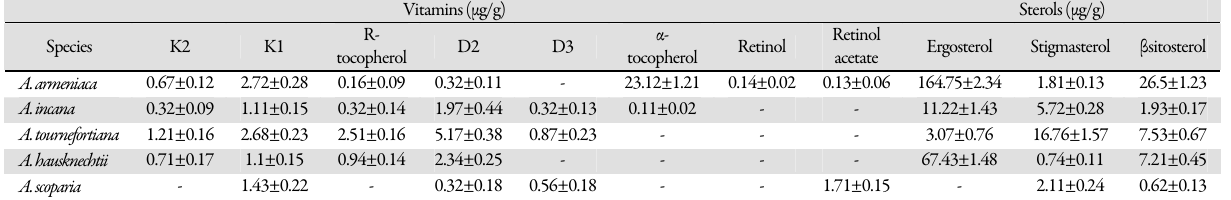
Table 3. Vitamin and sterol contents of investigated Artemisia